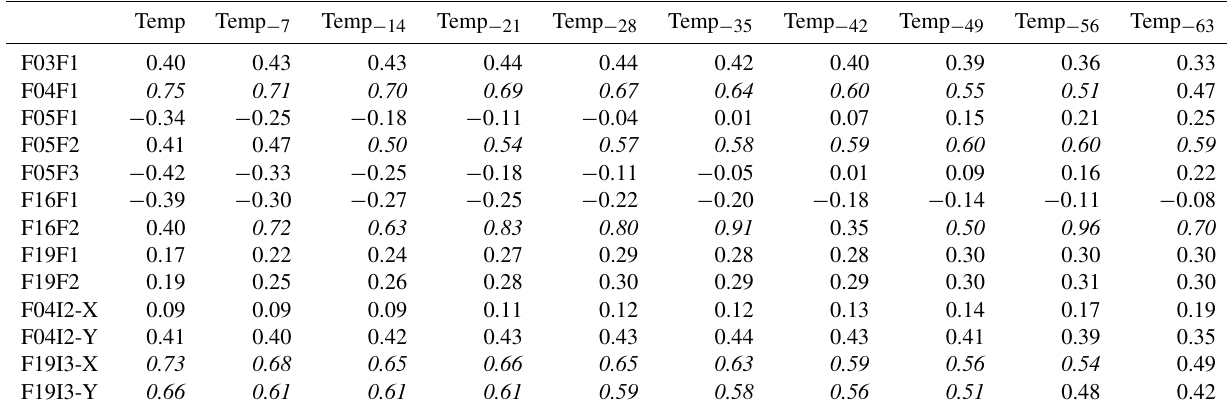
Table 12. Correlation matrix between tuff deformation data and air temperature for different time lags (expressed in number of days). The correlations greater than 0.5 are in italics.